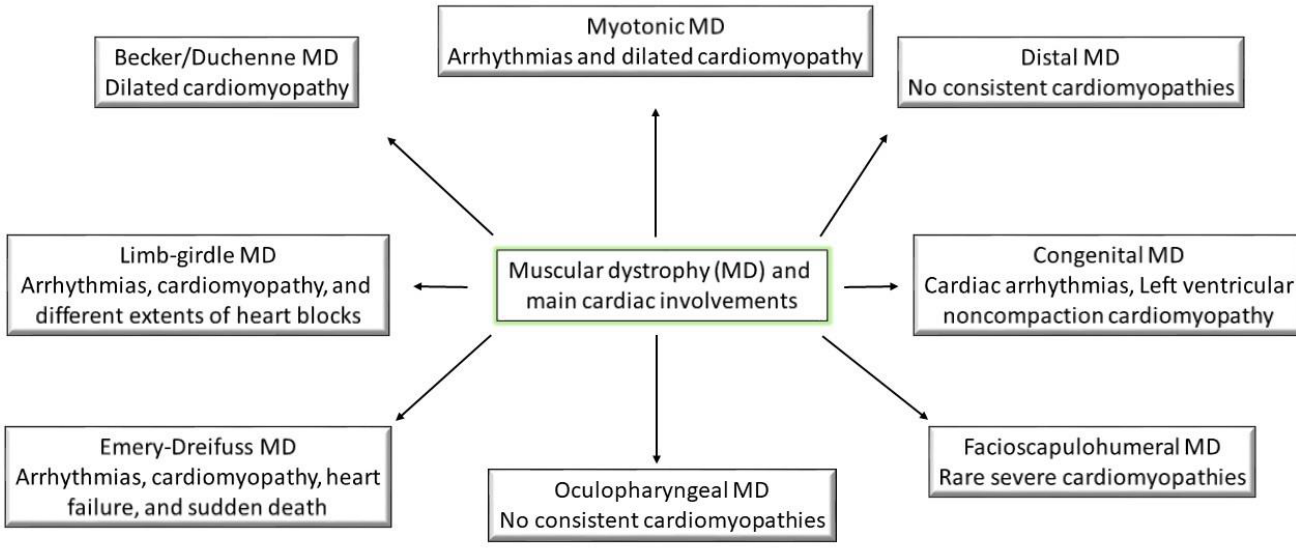
Figure 2. Muscular dystrophies and their main characteristic cardiac